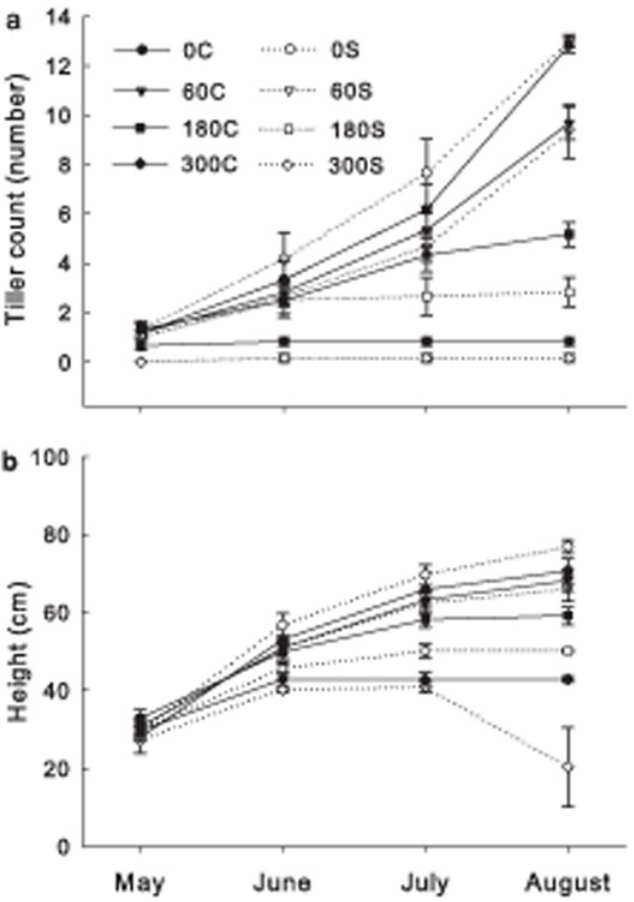
Fig 1. Effects of alkalinity stress, rhizome connection and data on the tiller number and height of subsequent ramets. Solid lines with 0C, 60C, 180C and 300C represented 0/0, 0/60, 0/180 and 0/300 mmol L -1 alkalinity levels in the rhizome-connected treatments, respectively; Dash lines with 0S, 60S, 180S and 300S represented 0/0, 0/60, 0/180 and 0/300 mmol L -1 alkalinity levels in the rhizome-severed treatments,